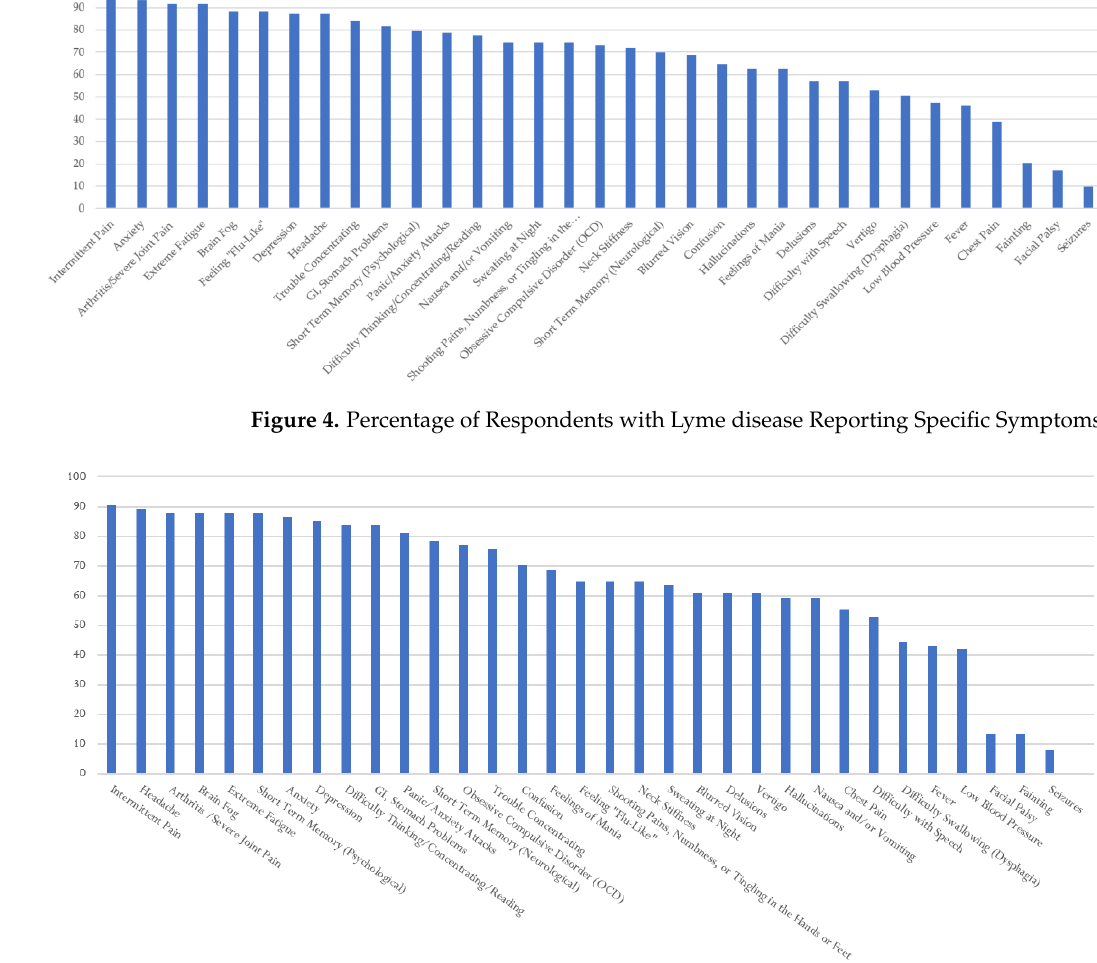
Figure 5. Percentage of Respondents with RMSF Reporting Specific Symptoms.